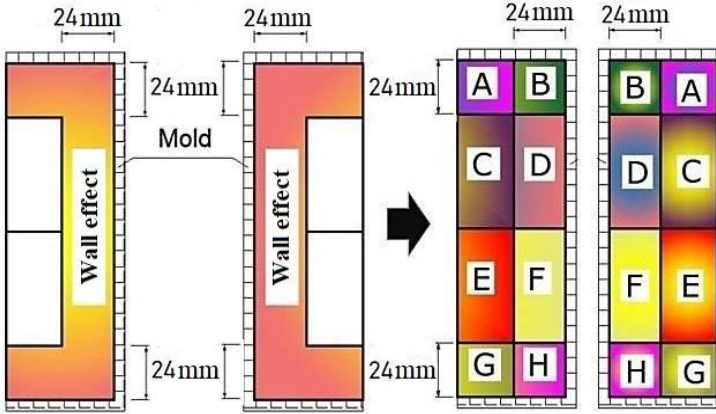
ff ect and zones for fibre counting in the fracture Figure 6. Mould wall effect and zones for fibre counting in the fracture surface. Figure 6. Mould wall e